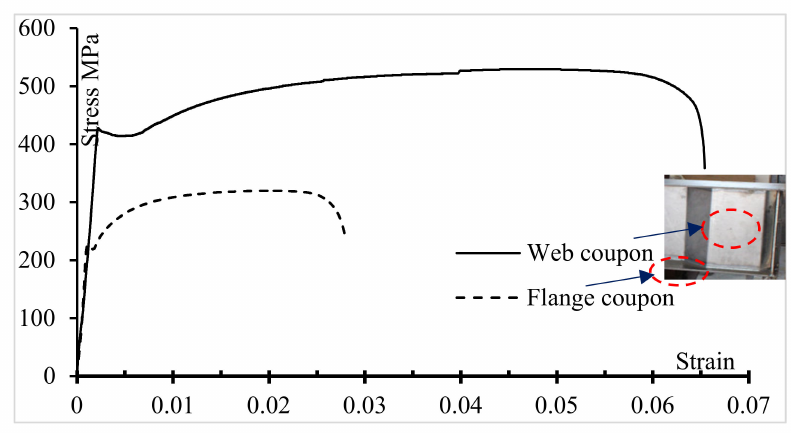
Figure 6. Stress-strain curves—Web and Flange